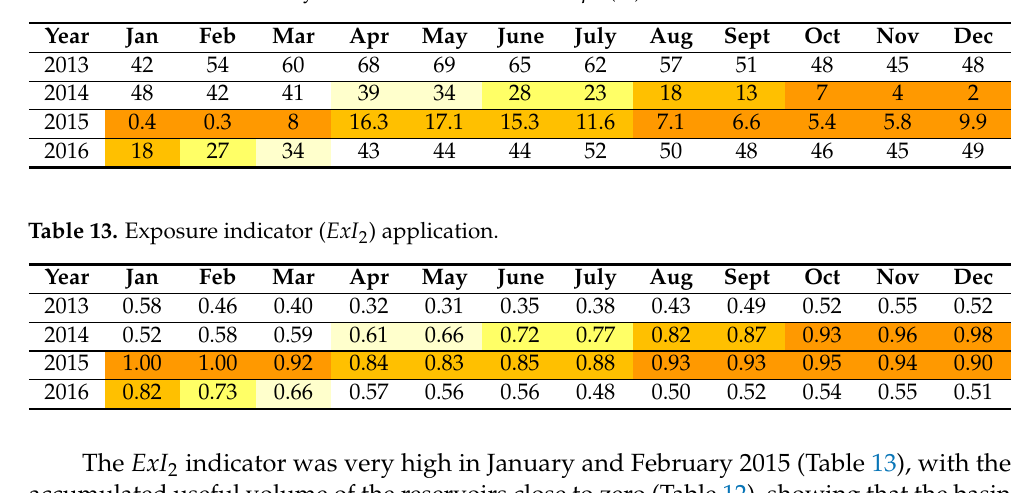
Table 12. Minimum monthly values of the indicator VEqR (%).